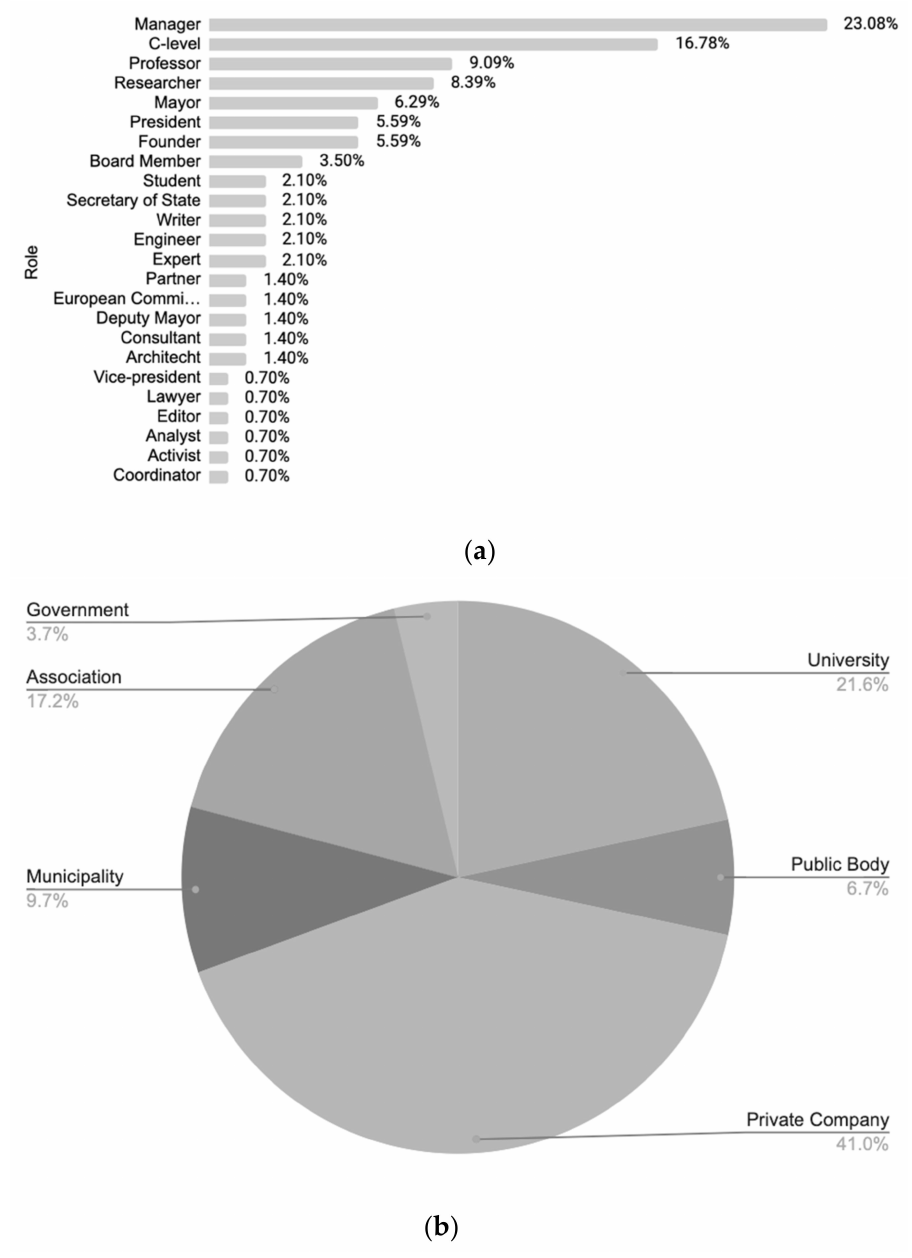
Figure 3. ( a ) Classification of the roles of the magazine’s contributors; ( b ) distribution of the entity types of the magazine’s